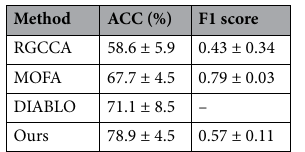
Table 5. Comparison of results on SEQC